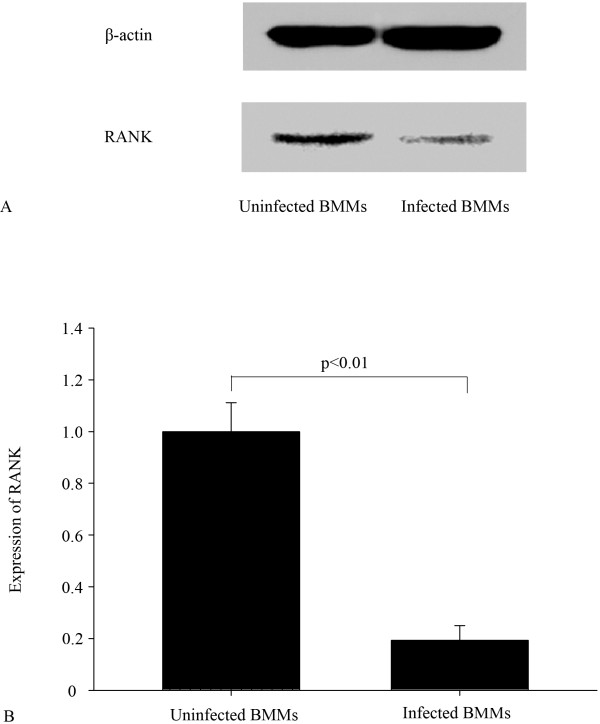
RANK silencing in BMMs by stable transduction by retroviruses. BMMs stably transduced with shRNA against the RANK were analyzed for RANK protein levels by Western blot (A, B); β-actin served as a loading control.